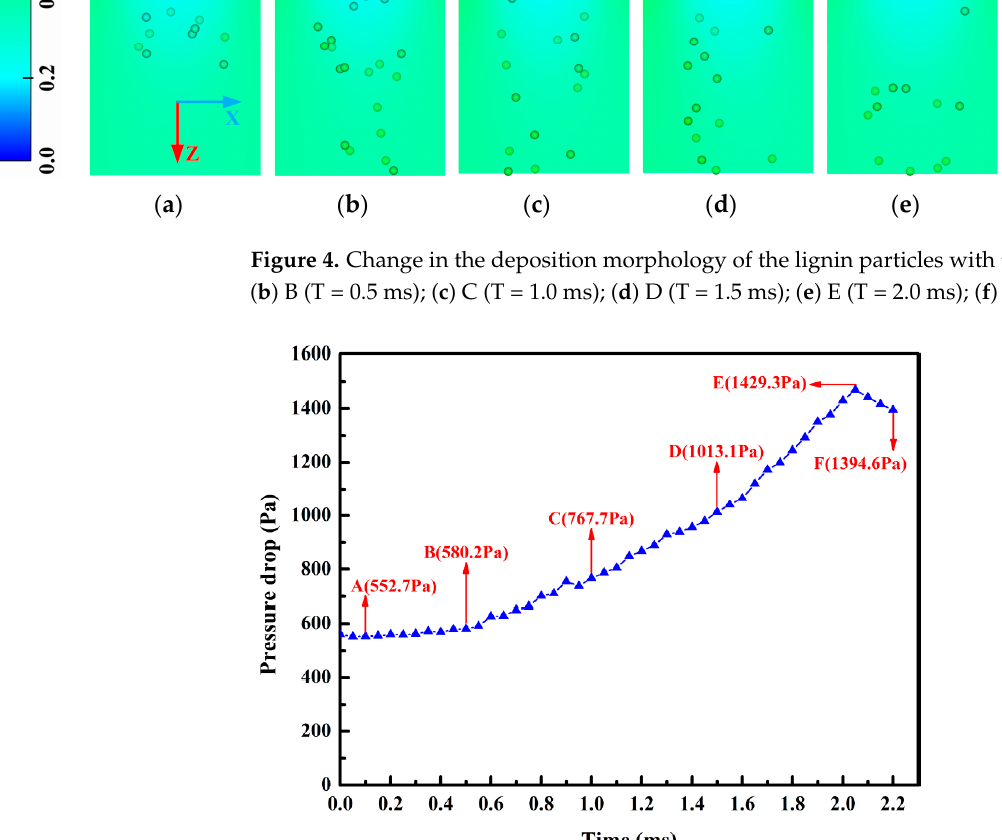
Figure 5. Pressure drop curve with time.